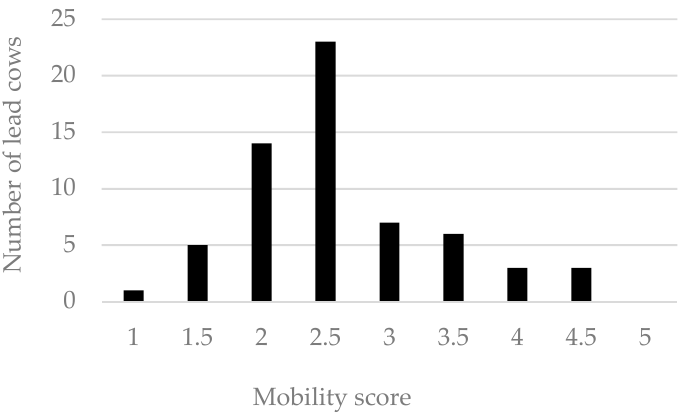
Figure 4. Mobility score of the lead cows of the pairs used in the preference trial. Cows were scored according to Manson and Leaver 1988 [17]. Of the 62 assessed individuals, 43 were classified as sound (mobility < 3) and 19 were classified as lame (mobility ≥ 3). For four additional pairs, the lead cow varied between the stretches, and their mobility score is omitted here.